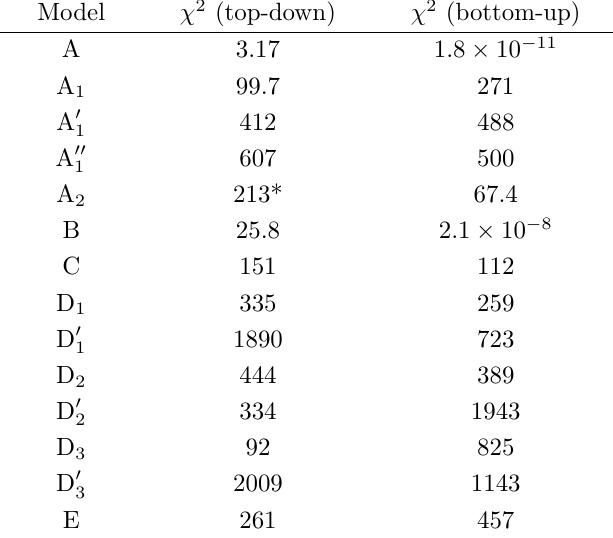
Table 3 . χ 2 values for the various models, both with top-down RG running and with the approx- imation of fitting at M GUT (labeled as “ χ 2 (bottom-up)”). An asterisk denotes a point that does not satisfy the inequality in eq. (2.15) and thus is not an acceptable